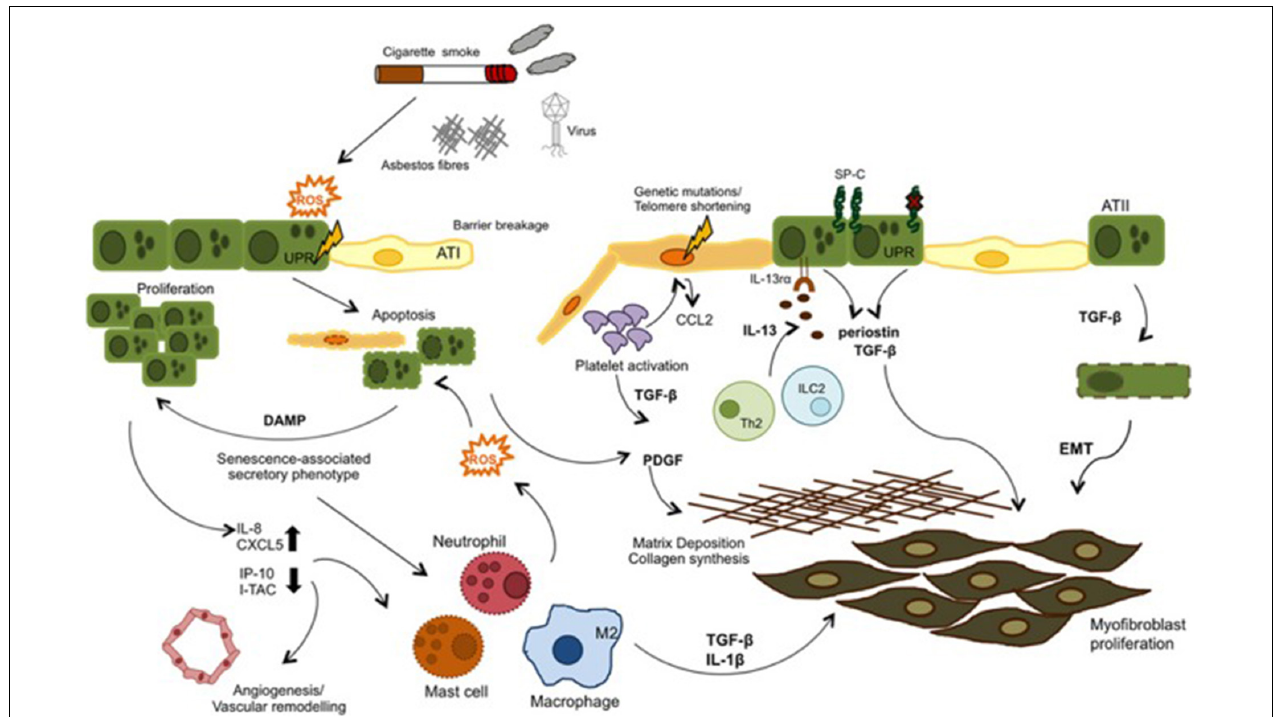
FIGURE 6 | Mechanisms of external noxious on epithelia mesenchymal transition.